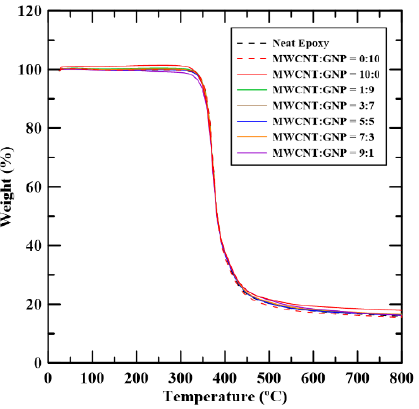
Figure 9. Relationship between the weight loss of the epoxy composites with various MWCNT:GNP ratios and temperatures obtained using TGA analysis.